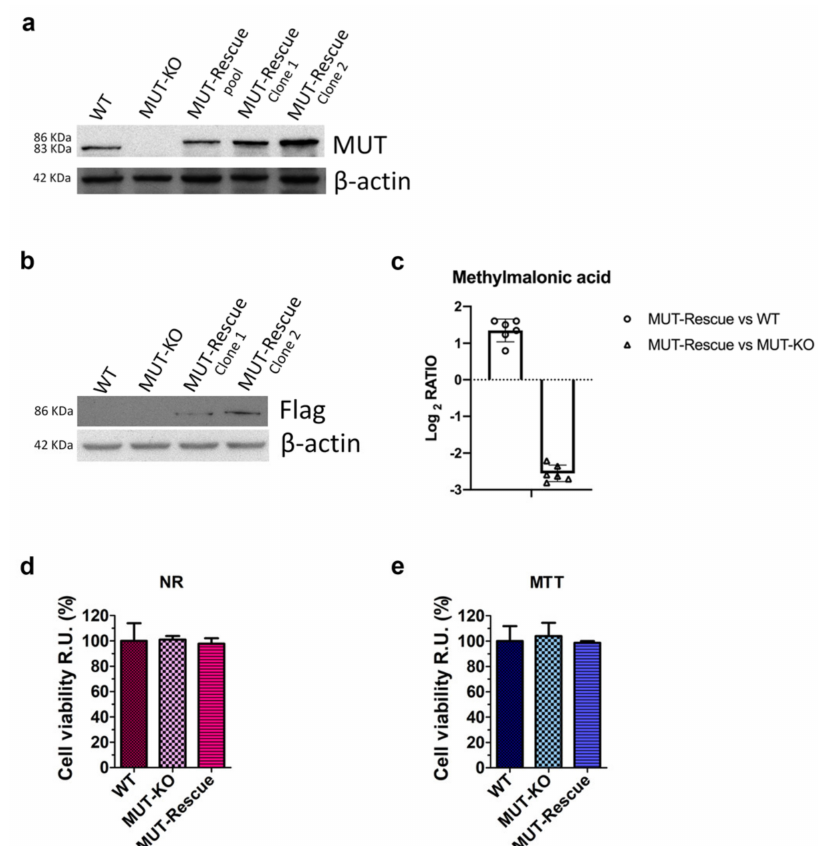
Figure 5. Western blot and cell viability analyses of MUT-KO cells after a stable transfection-mediated MUT expression rescuing. ( a ) WB analysis of the whole Flag-MUT plasmid-transfected MUT-KO clone 2 cell population after selection with hygromycin (MUT-Rescue pool) and two single cell clones (namely, MUT-Rescue clone 1 and 2) isolated from the MUT-Rescue pool. ( b ) MUT-Rescue clone 1 and 2 were also analyzed with an anti-Flag antibody to confirm the expression of recombinant Flag-MUT. WT and MUT-KO were used as a control; β -actin was used as a loading control. ( c ) Methylmalonic acid was measured by targeted LC-MS / MS in MUT-Rescue and compared to WT and MUT-KO levels. Concentrations were normalized to the protein content of each sample and calculated as µ M based on 1 mg of protein per cell extract. Data are reported as the mean of six biological replicates ± SEM. The p -value for the comparisons is ≤ 0.001. Comparison of cell viability in WT, MUT-KO, and MUT-Rescue cells by ( d ) Neutral-red (NR) and ( e ) MTT assays. The experiments were performed in four independent biological replicates. Absorbance values were normalized to those of WT cells (used as a control) and were, hence, expressed as cell viability percentage relative units (RU). Data were reported as averages of four biological replicates and error bars represent SD. A one-way two-tail paired t -test was used to calculate the statistical significance of di ff erences between the three groups. However, no statistically relevant di ff erence was